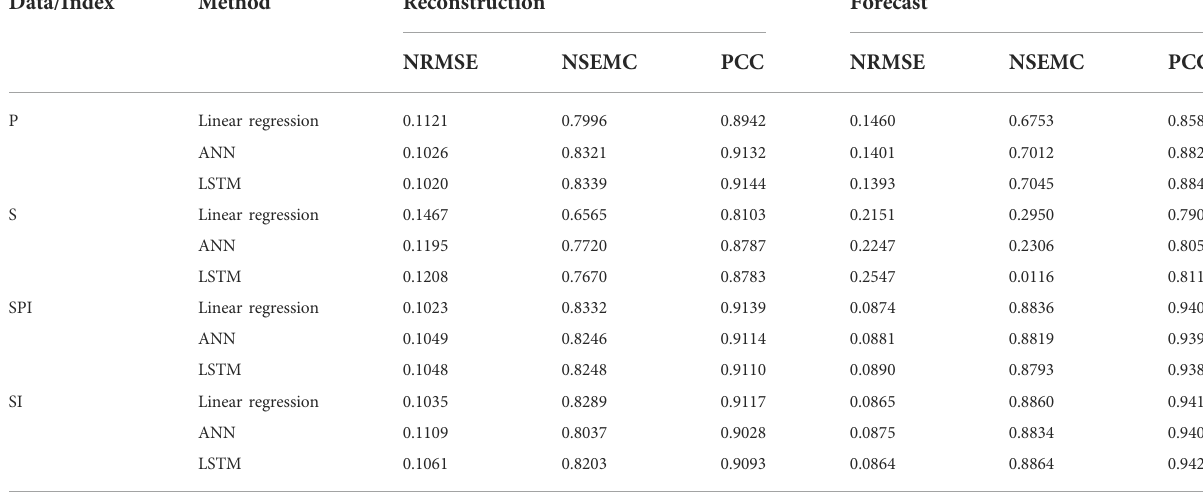
TABLE 2 Evaluation of runoff reconstruction and forecast at the Kratie